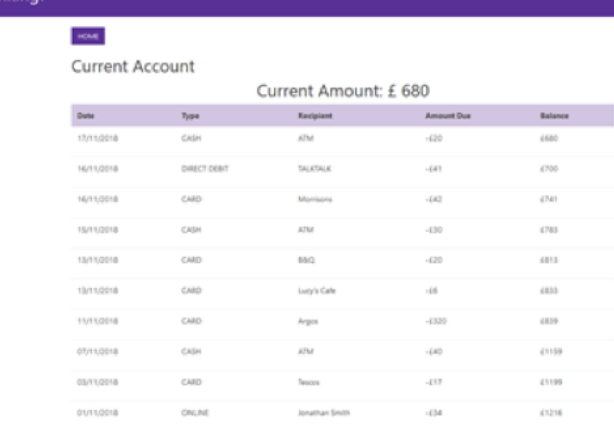
Figure 4. A screenshot of the transaction view page of our flat UI.